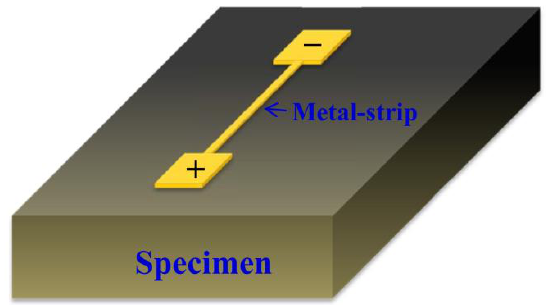
Figure 1. Schematic of a typical measurement arrangement of the 3 ω method.